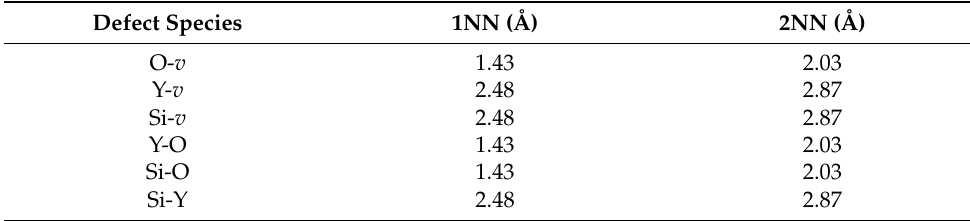
Table 3. Nearest neighbor (NN) distances between different interacting partners.